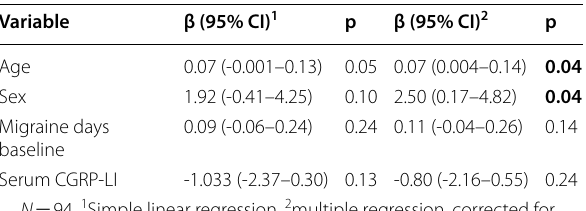
Fig. 1 Change in serum log[CGRP-LI] between T0 and T1 (2–4 weeks after starting erenumab) separated for patients with < 50% and reduction in monthly migraine day (MMD) reduction after three months of treatment. Data presented as mean Table 2 Linear regression analysis with log-transformed serum CGRP-LI levels (mol/l) T0 Variable